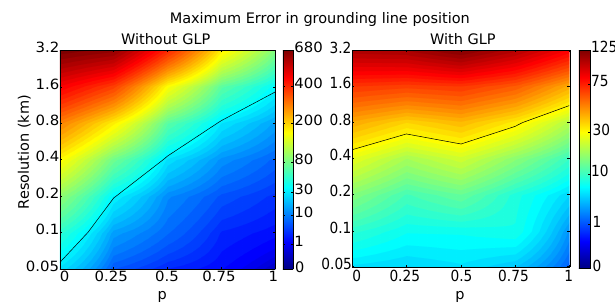
Figure 7. The maximum error over the advance and retreat exper- iments between the fixed-grid and benchmark grounding-line posi- tion over a linear bed for simulation without the GLP (left column) and with the GLP (right column). The errors are bilinear interpola- tions of our 35 experiments (5 values of p and 7 resolutions). The black line shows a contour of 30 km error ( ∼ 5% of the differ- ence between the most advanced and the most retreated positions of the benchmark), below which we deem the error to be suffi- ciently small. Note that each panel uses a different nonlinear color bar. Without the GLP, the maximum error decreases approximately linearly with resolution and superlinearly with p . With the GLP the maximum error decreases weakly with respect to p but approxi- mately linearly with